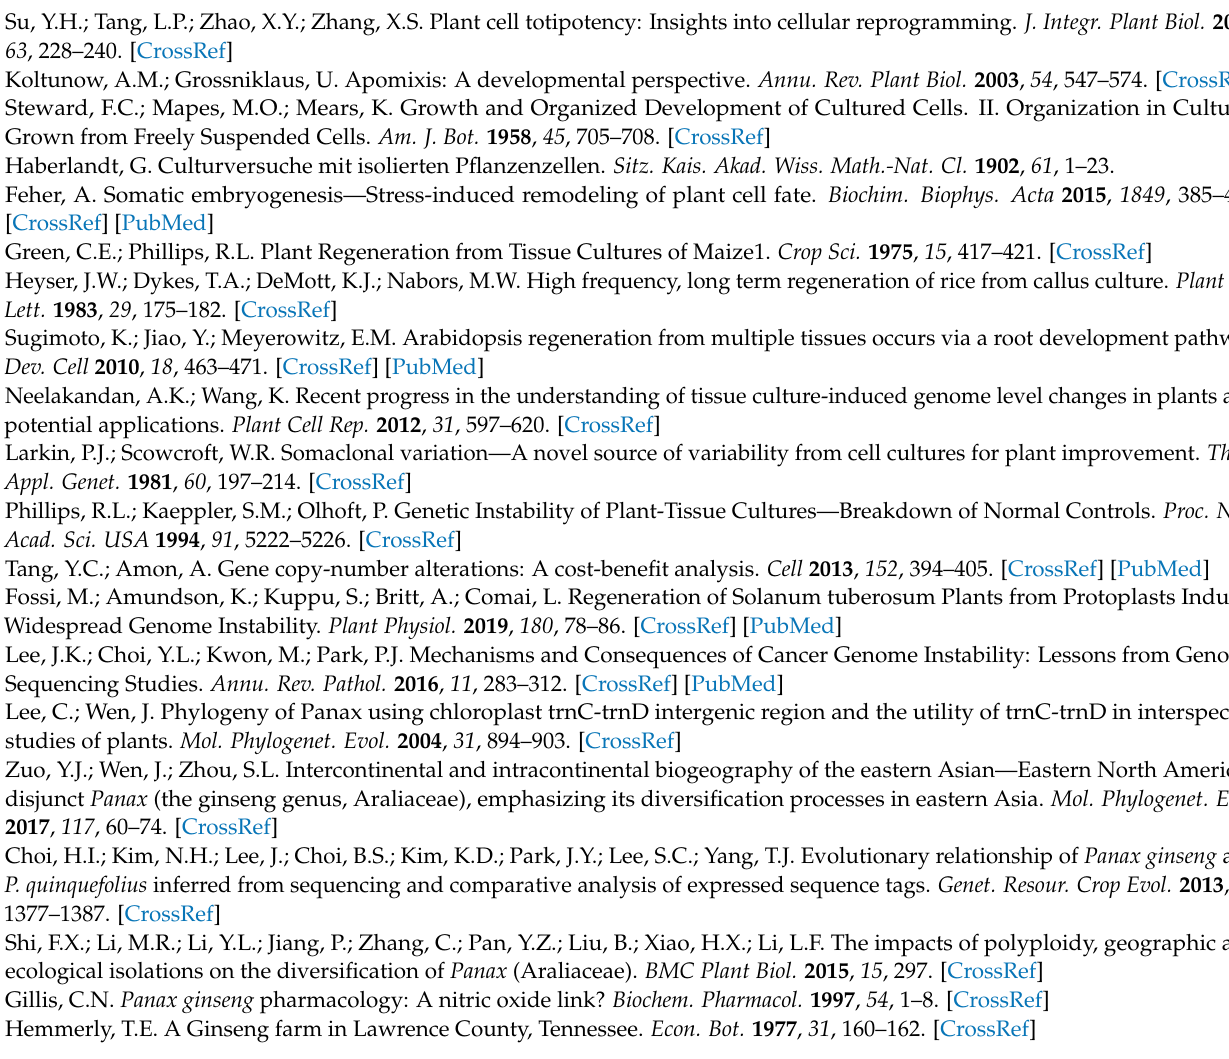
y_2017. Table S1. Basic information of the raw data in the three ginseng callus-regenerated plantlet samples. Table S2. Summary of the non-synonymous and synonymous mutations in the three ginseng callus-regenerated plantlet samples. Table S3. Totipotency- and chromosome stability-related genes in the ginseng genome. Table S4. Mutation type of the totipotency-related genes. Table S5. Mutation type of the chromosome stability-related